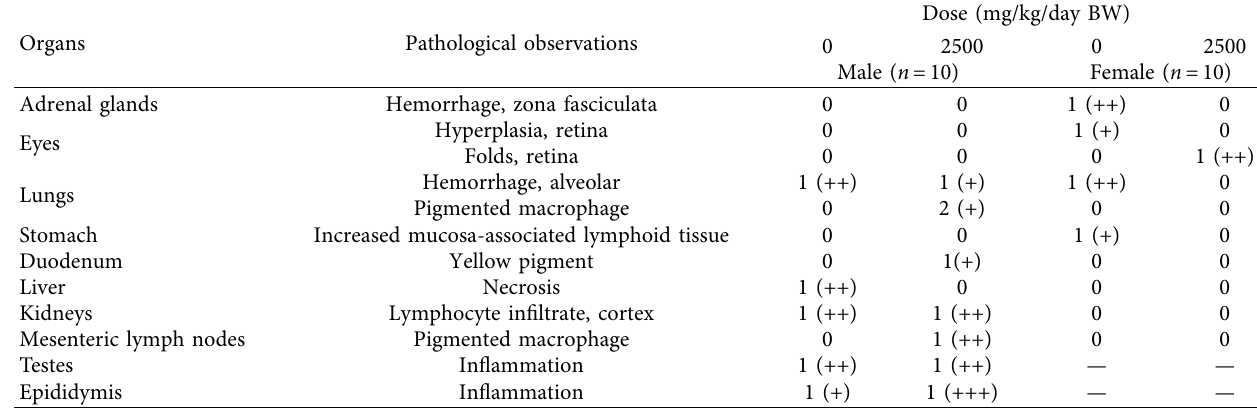
Table 8: Summary of histopathological changes in the vital organs of the male and female rats after 90-day oral administration of LN18178.